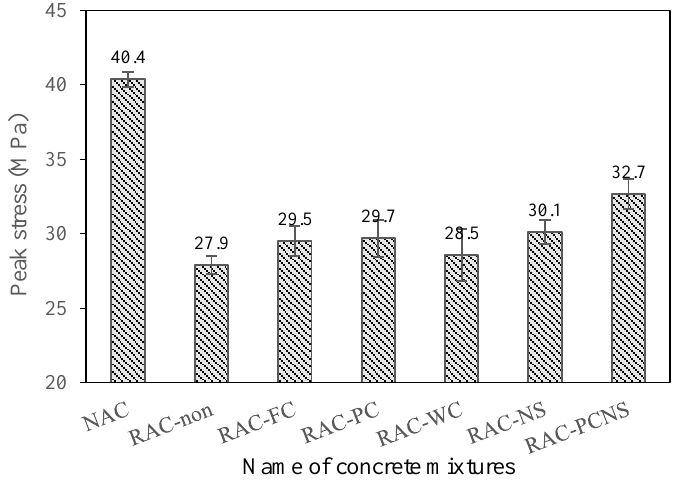
Figure 6. Peak stress of hardened concretes.